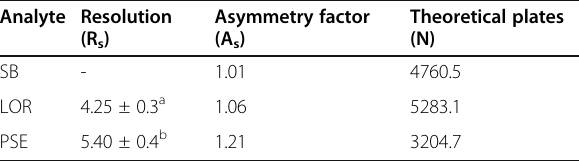
Table 4 System suitability parameters from optimization mixture analysis